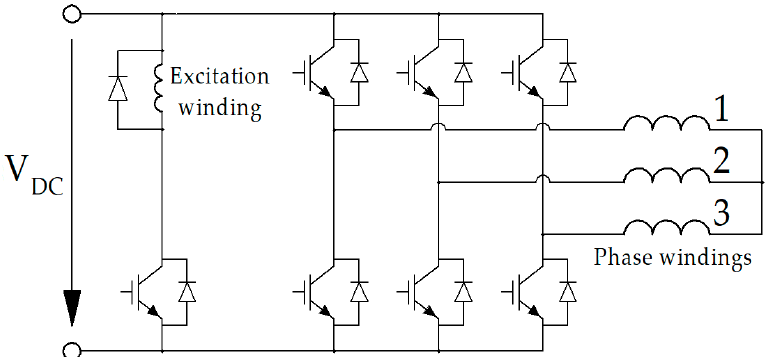
Figure 2. Diagram of a three-phase inverter with a DC breaker for the excitation winding, where ‘1,2,3’ are numbers of the phases of the SHM armature winding.